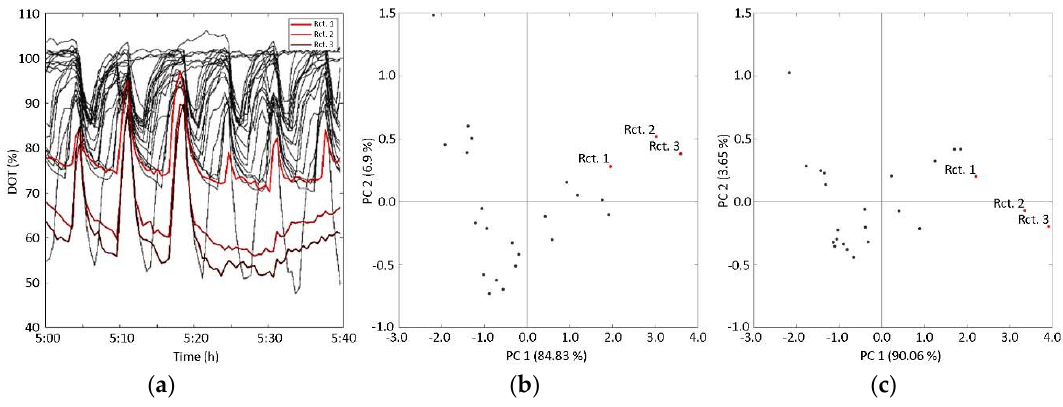
Figure 6. Reactor overfill. ( a ) Trajectories of the DOT profile from 05:00–05:40 h with highlighted reactors (1,2,3; highest feed rate). The pattern of peaks corresponds to the pulse ‐ based feeding. ( b , c ) Score plot of the first two PC. The sliding window PCA model was built with data from 05:00–05:20 h (b) and 05:20–05:40 h (c) into the cultivation, respectively. The variance explained by the PC is indicated in percent in parenthesis.